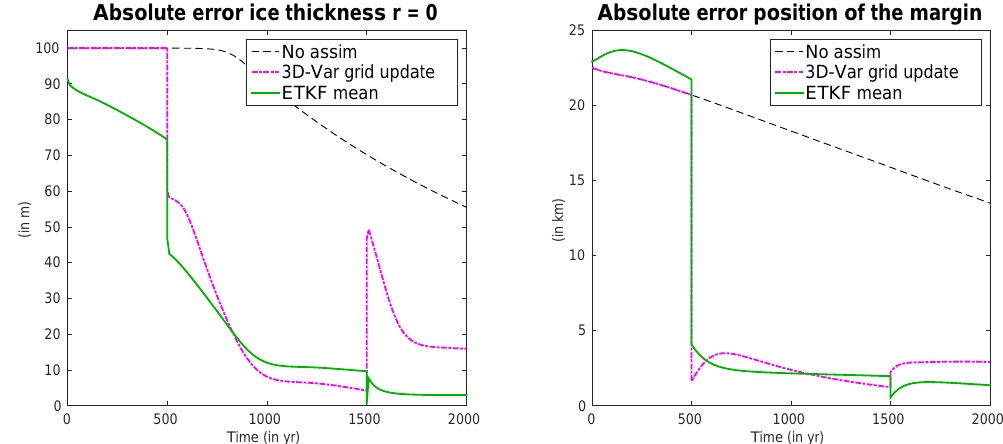
Figure 11. Evolution of the absolute error of the estimated ice thickness at r = 0 and the estimated position of the margin when we observe the ice thickness and the position of the margin. We compare the absolute errors obtained when we use 3D-Var with correction of the position of grid nodes and when we use an ETKF. In both experiments, the results are improved with respect to the position of the margin (compared to results detailed in Fig. 9). No improvement (nor degradation) is observed for the ice thickness at r =